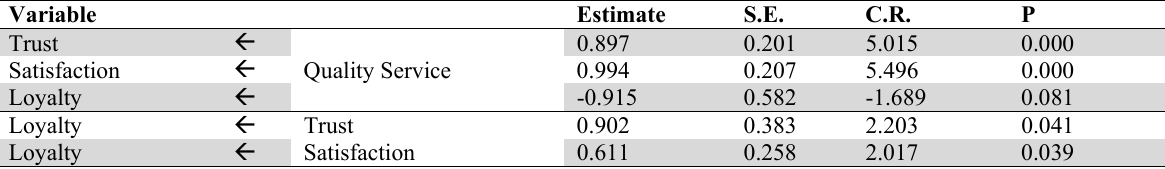
Hypothesis Testing